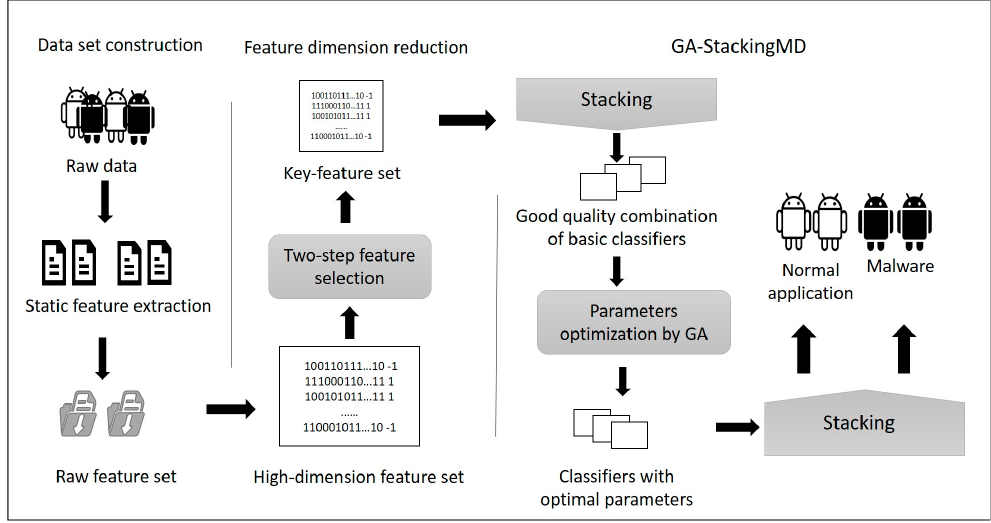
Figure 2. The GA-StackingMD